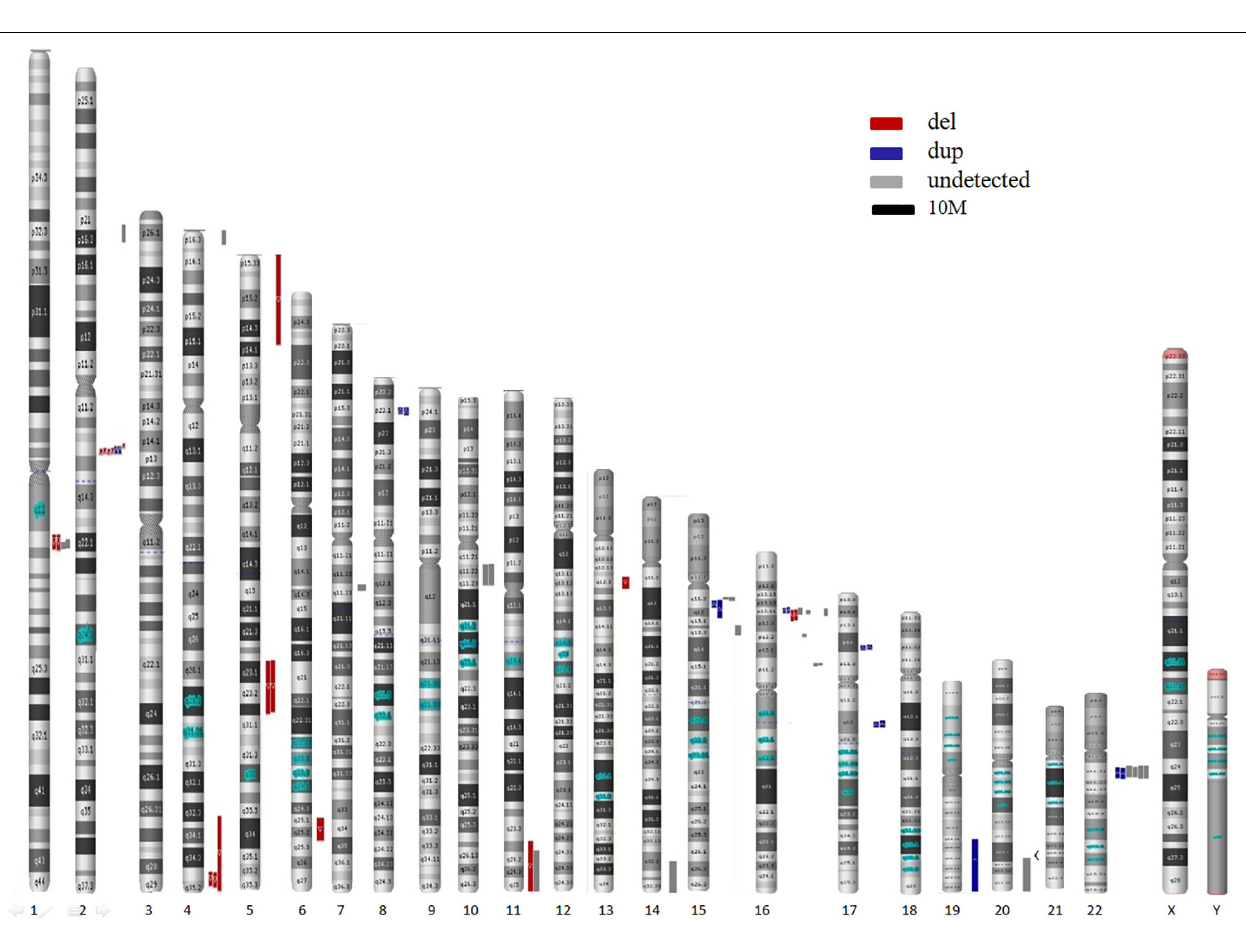
FIGURE 2 | Map of all CNVs identified in the present